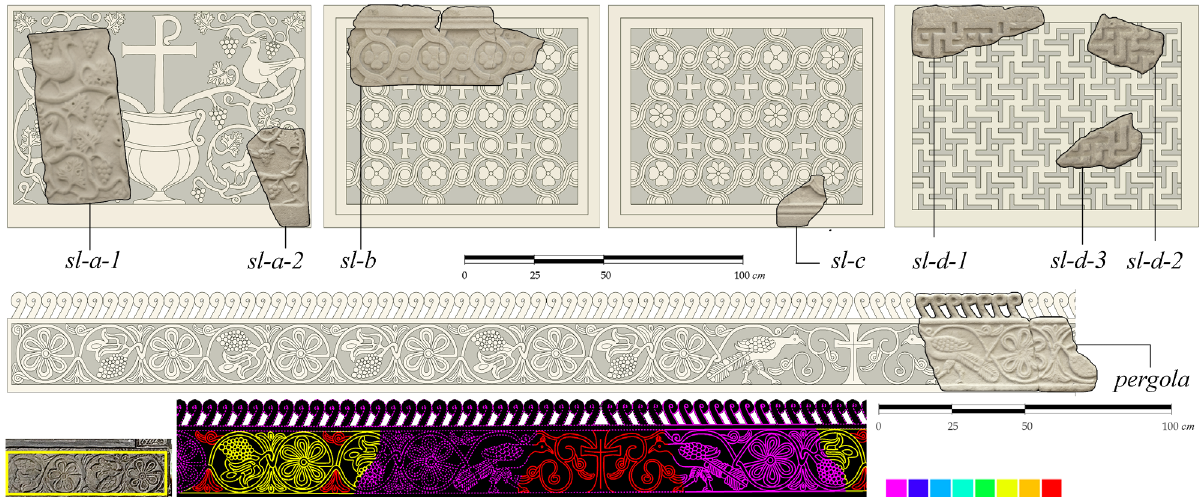
Figure 9. Uncertainty scale for reconstruction applied to 2D decorative elements of pergola ; fragments integrated with